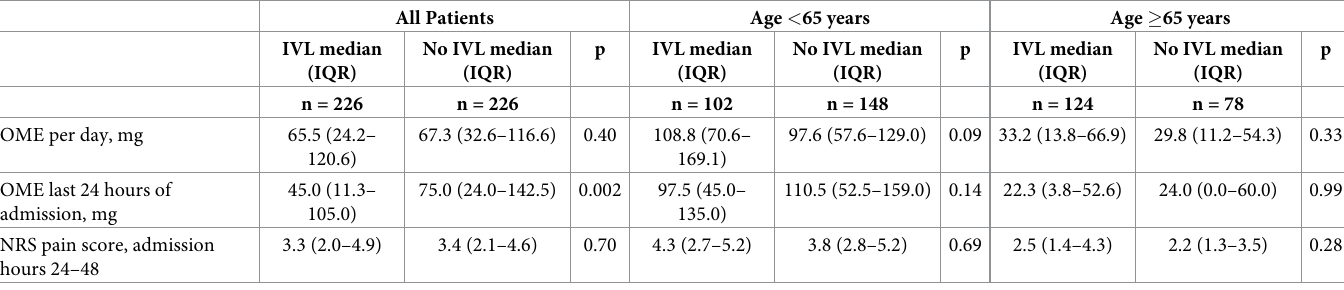
Table 3. Primary outcome comparison of patients on vs not on IVL infusion; all propensity score-matched patients and patients stratified by age subgroups. All